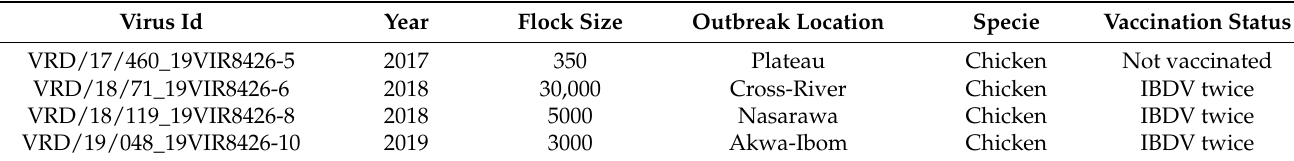
Figure 1. Map of Nigeria showing the locations where the samples were obtained for the study. Table 1. Epidemiological information on the IBD outbreaks from the investigated locations in Nigeria.